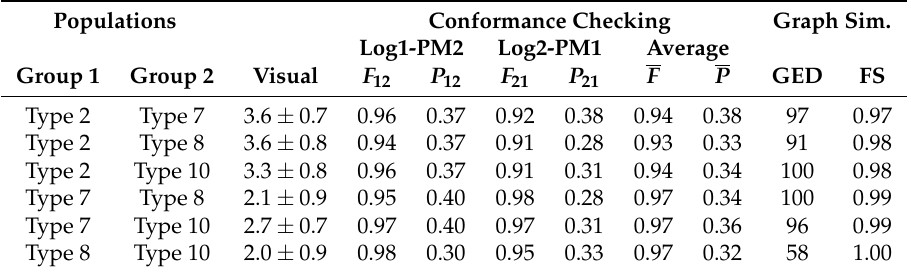
Table 3. Process comparison on MIMIC. Visual impression (Visual), conformance checking